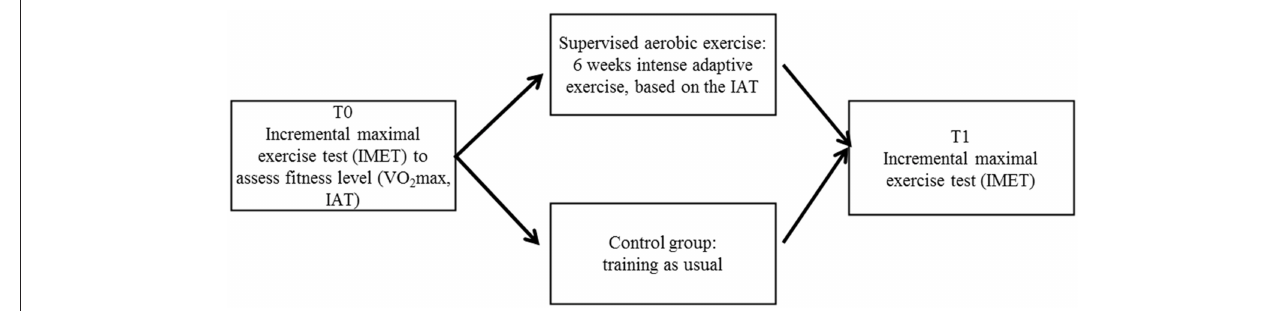
FIGURE 1 | Flow chart of the study.